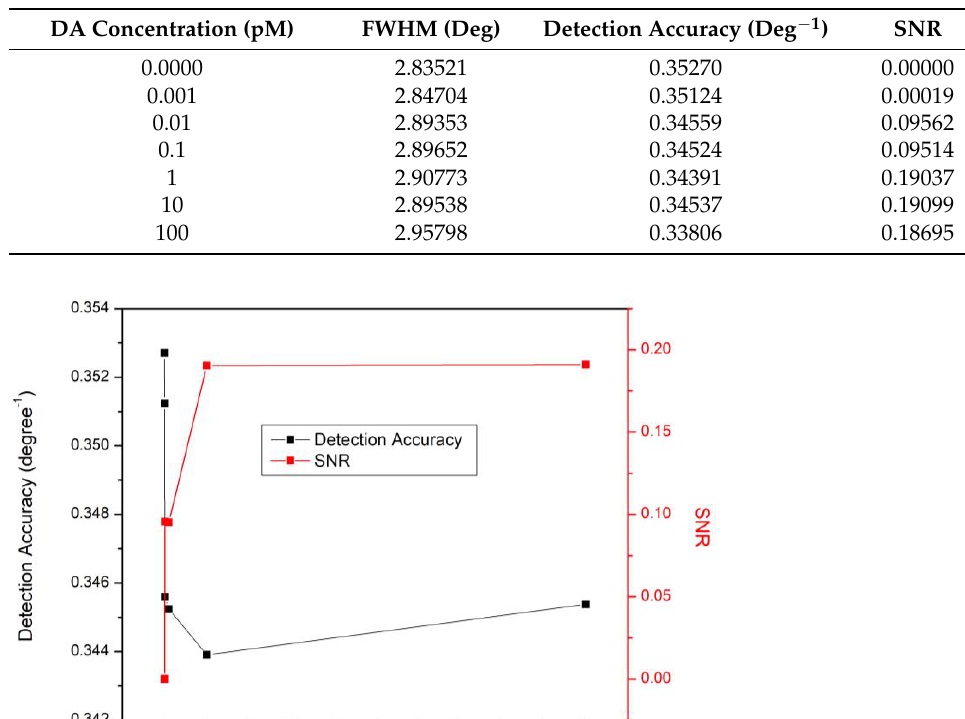
Table 3. The FWHM, detection accuracy, and SNR values of the CQD-based SPR sensor in response to varied DA concentrations. Figure 8. Experimental and fitted data to the Sips model for DA adsorption on CQD sensor film.